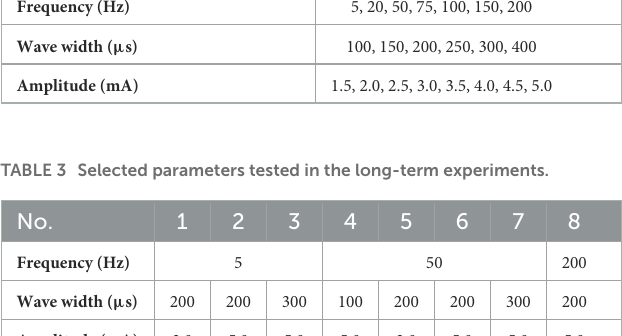
TABLE 2 Ranges of potential parameters that were pre-determined after the test experiment in section 2.2.2. Frequency (Hz)